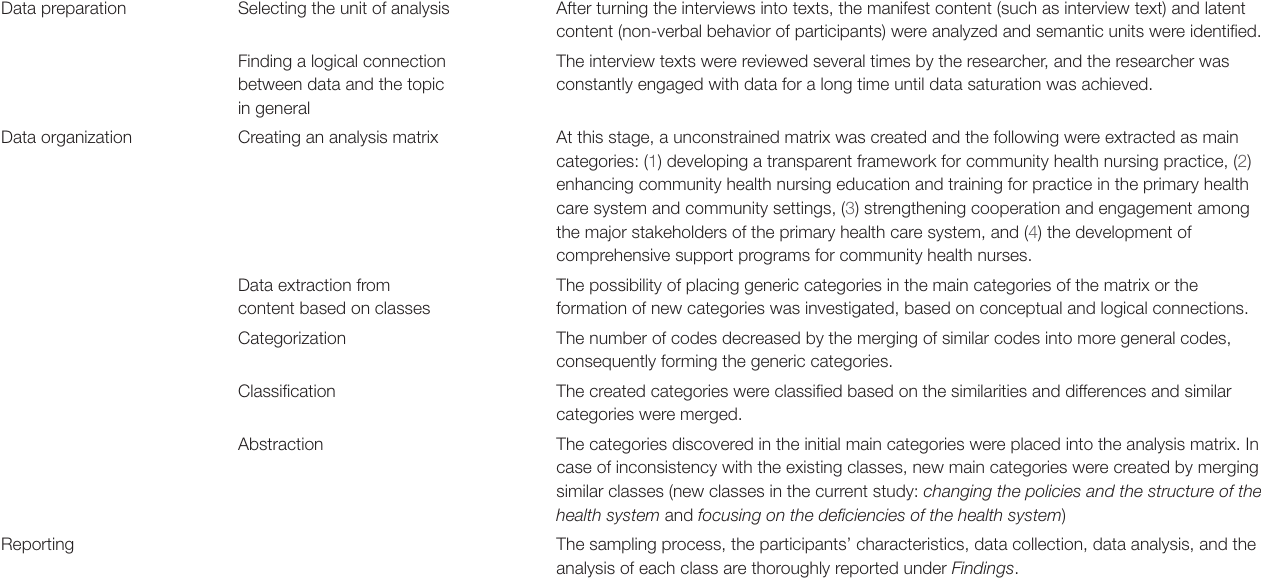
TABLE 1 | The process of qualitative data analysis based on Elo & Kyngas’ Method.